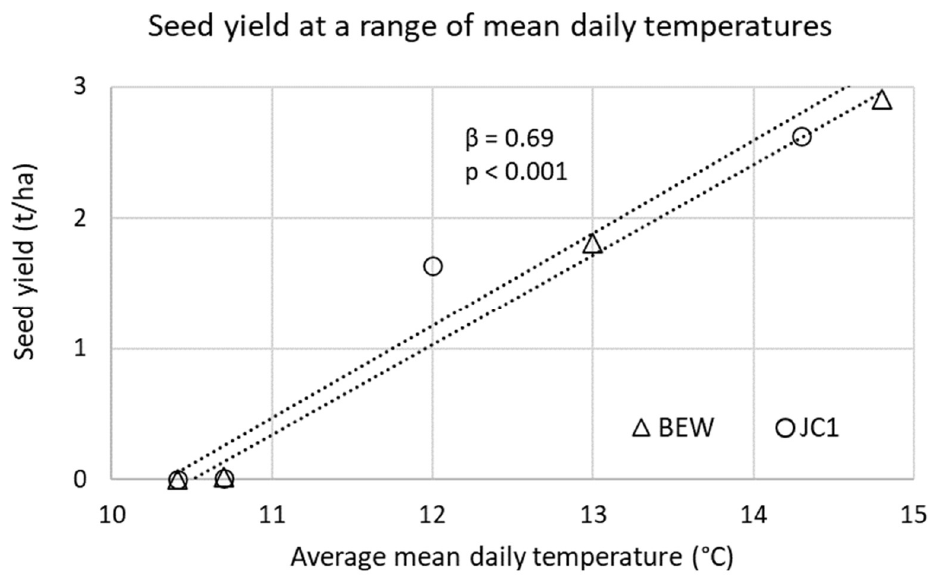
21 of 31 Figure 3. Relationship between seed yield (t/ha) and average mean daily temperature (°C) during the seed development stage for selected field trials where water was presumed not to be limiting production (i.e., all irrigated field trials, excluding Leeton—March, and including the rain-fed site at Geraldton). 3.4. Low Temperatures during Flowering There was a clear decreasing trend in seed yield with decreasing average mean daily temperatures during the flowering period of varieties BEW and JC1 (Figure 4). For every 1 °C decrease in temperature below 15 °C seed yield declined by 690 kg/ha. Average mean daily temperatures below 11 °C and frequent days with freezing conditions were associ- ated with near zero seed yields at Cunderdin in 2016 (Table 17). Temperature and rainfall (or irrigation in the case of Leeton) during the seed development stage at these sites were not considered to be a limitation for seed production. Table 17. Weather records at Cunderdin, Leeton and Geraldton field trial sites for the 30-day period after commencement of flowering of varieties BEW and JC1 (figures separated by a comma are data for BEW followed by data for JC1). Field trial